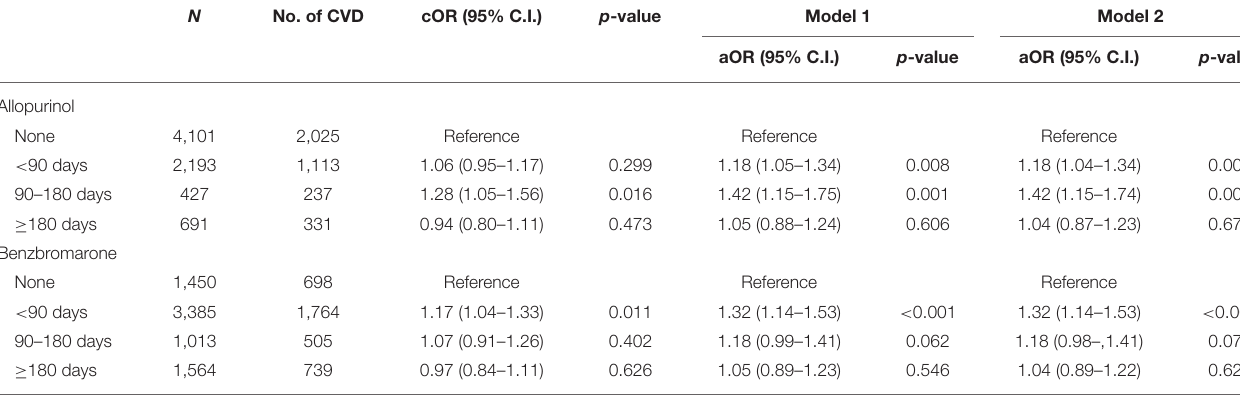
TABLE 2 | Logistic regression of risk of CVD divided by usage days of allopurinol and